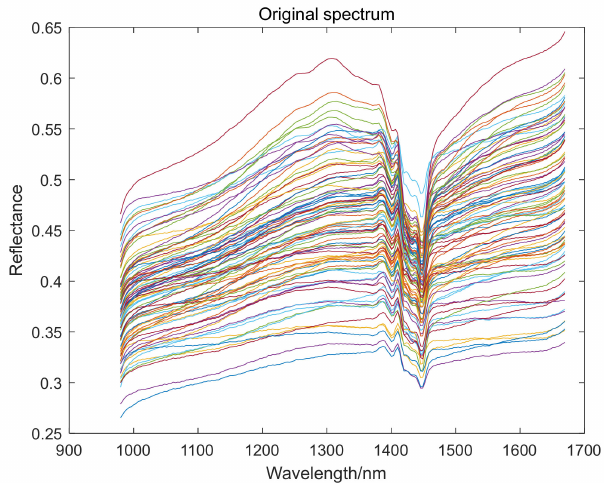
Figure 2. Spectral curve of rubber plantation soil samples in Danzhou City,